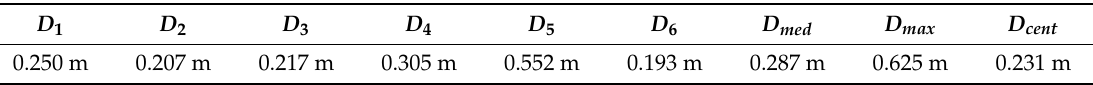
Table 4. Results derived from the six measurements taken with a measuring tape following the traditional